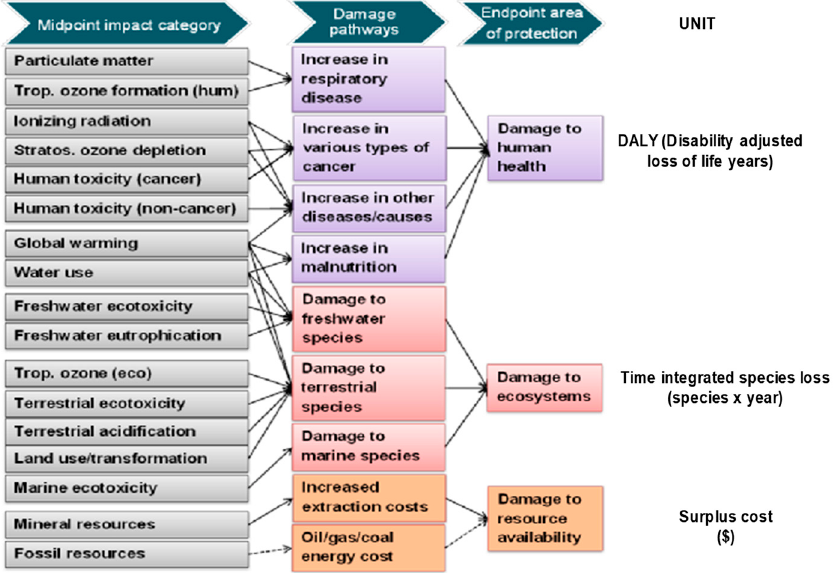
Figure 2. Overview of the impact categories that are covered in the ReCiPe methodology and their relationships to the damage to human health, damage to ecosystems and resource availability are highlighted [4].